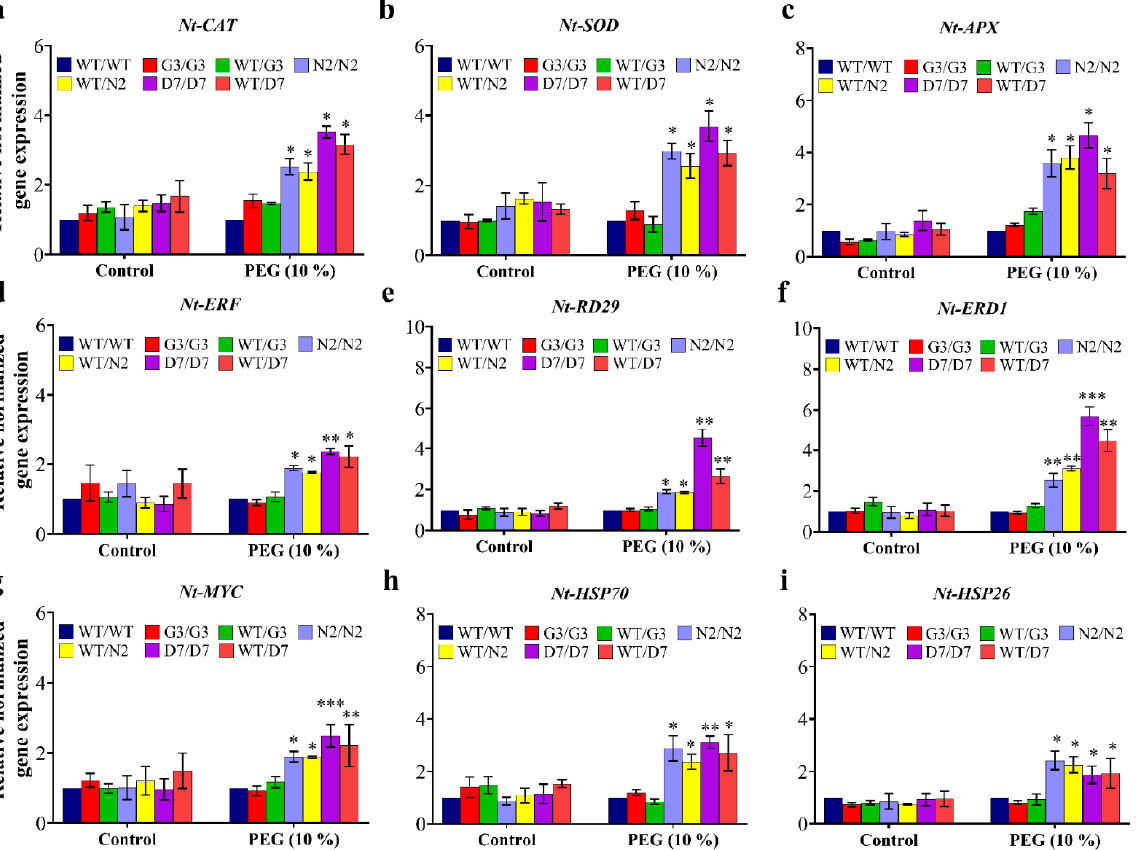
Figure 11. Gene expression analysis in transgrafted tobacco plants under osmotic stress conditions. Normalized relative gene expression of ( a ) NtCAT , ( b ) NTSOD , ( c ) NtAPX , ( d ) NtERF , ( e ) NtRD29 , ( f ) NtERD1 , ( g ) NtMYC , ( h ) NtHSP70 , and ( i ) NtHSP26 genes three days after stress treatment. Genes differentially expressed in plants under stress conditions were normalized with NtEF1 . WT/WT, G3/G3, WT/G3, N2/N2, WT/N2, D7/D7 and WT/D7 are grafting combinations. The bars represent mean values ± SEM of three biological replicates (four plants each). Asterisk(s) indicate(s) significant differences between the means of WT/WT and transgrafts of each treatment group at * p < 0.05, ** p < 0.01, *** p < 0.001 according to Dunnett test.